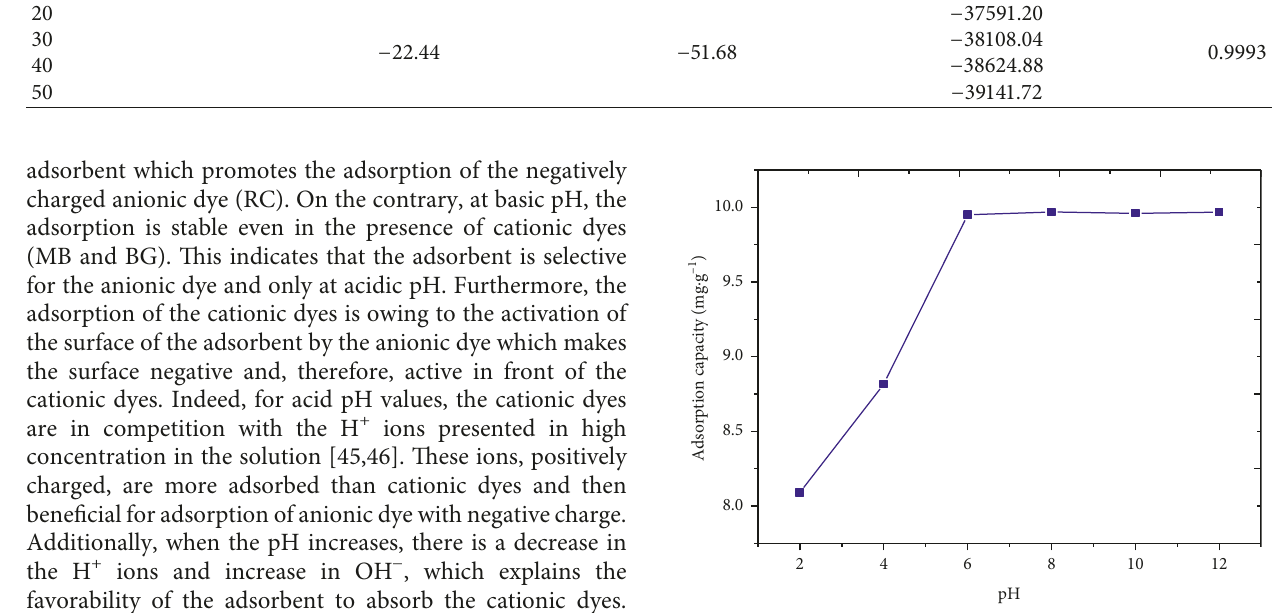
Figure 9: pH effect on PB adsorption capacity. m � 2g · L − 1 ; [DM]